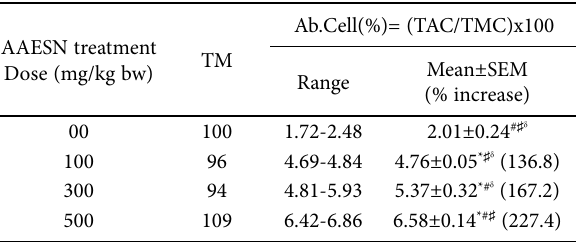
Table 1. Pooled data showing the AAESN induced aberrant cell percentage of WRBMCs.